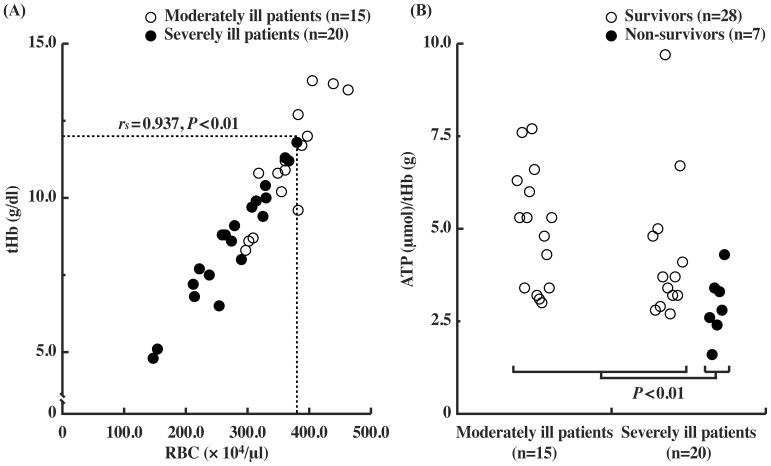
Blood ATP levels correlate with RBC count and ATP levels in ICU patients.(A) Correlation between tHb (total hemoglobin) and RBC count in the available data of moderately (n = 15) and severely ill patients (n = 20) during the ICU stay. The Dotted lines represent the lower limits of tHb and RBC count of healthy subjects. (○): moderately ill patients, (•) severely ill patients. (B) ATP concentration in whole blood, expressed as micromoles ATP per gram total hemoglobin (µmol/g tHb) in ICU patients. (○): survivors, (•) non-survivors. The values of ATP/tHb in non-survivors were significantly lower than those in survivors (P<0.01).